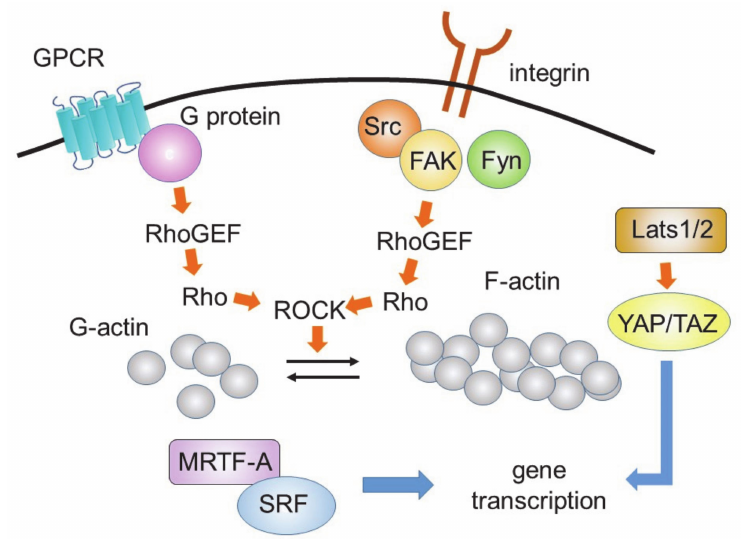
Figure 3. Rho- and YAP/TAZ-mediated signaling